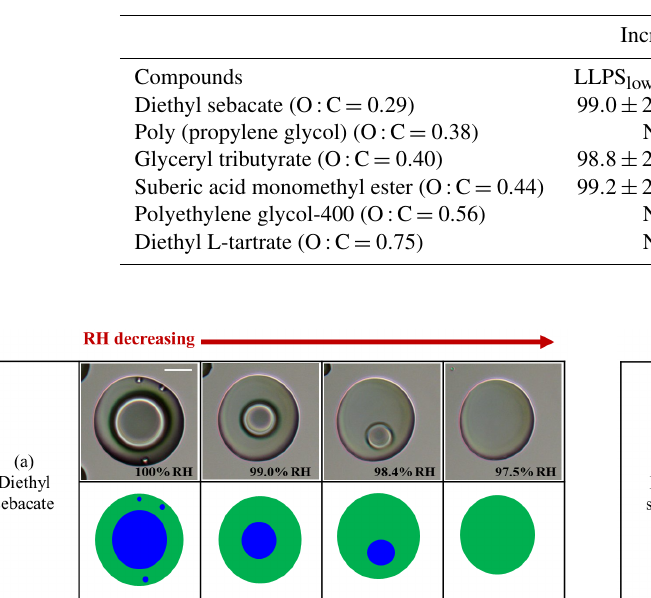
Table 2. Lower RH boundary for LLPS (LLPS lower ) and upper RH boundary for LLPS (LLPS upper ) for particles containing one organic species. LLPS lower and LLPS upper represent to the lowest and highest RH at which two liquid phases were observed in the experiments. Uncertainties represent 2 σ of multiple measurements and the uncertainty from the calibration. “No LLPS” indicates that only one phase was observed for the full range of relative humidity explored ( ∼ 0 to 100% RH).